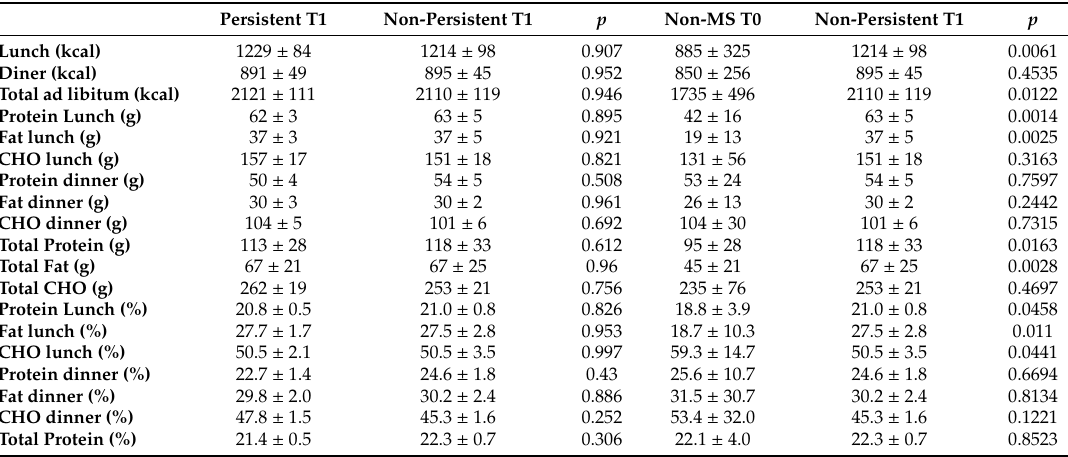
Table 4. Ad libitum energy intake and macronutrient choices in persistent vs. non-persistent adolescents at T1 and among non-MS T0 and non-persistent at T1. Persistent